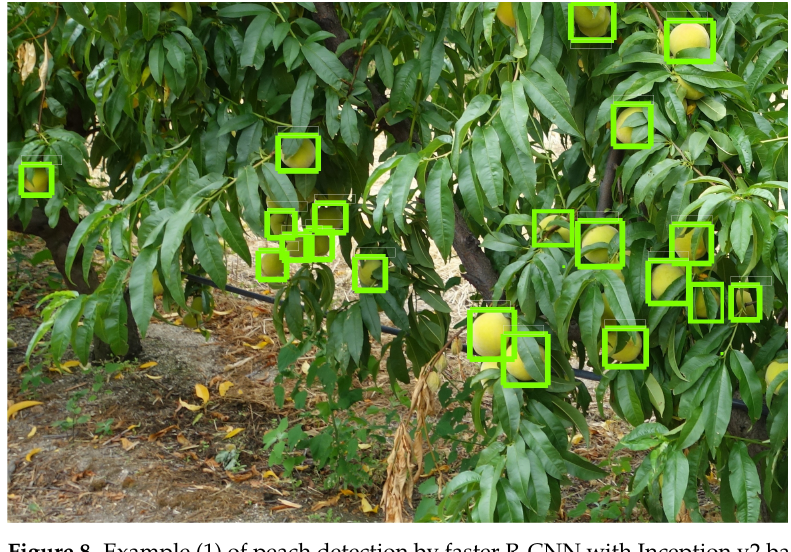
Figure 8. Example (1) of peach detection by faster R-CNN with Inception v2 backbone.